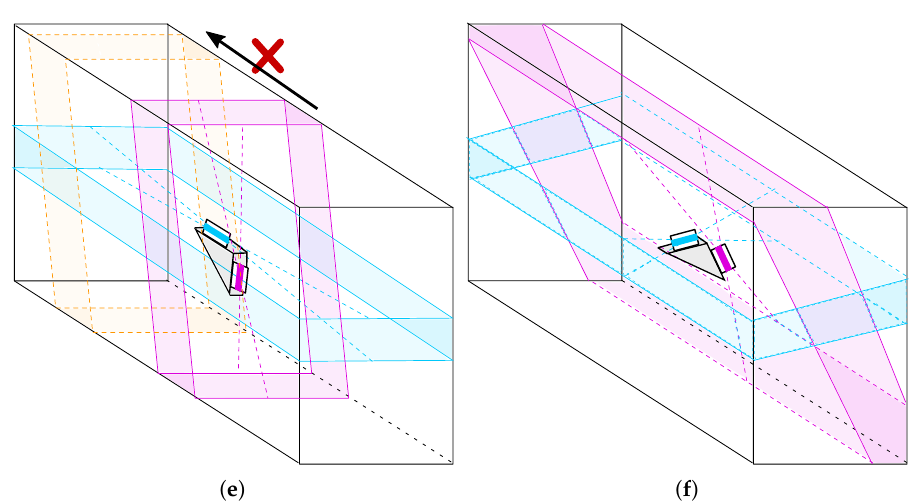
Figure 6. Various configurations of LiDAR scanners in worst case scenarios we have encountered in our experiments: narrow corridor ( a , c ) and staircase ( b ). The field of view (30 ◦ for Velodyne Puck) is displayed in color. When only single LiDAR ( a ) was used, the scans did not contain 3D information of the floor or the ceiling (red cross). The situation was not improved when the scanner is tilted because of failing in, e.g., staircases ( b ). When we added a second LiDAR, our tiled asymmetrical configuration ( d ) provides better top–bottom and left–right observation than the symmetrical one ( c ). Moreover, when the LiDARs are aligned in direction of movement ( e ), there is no overlap between current (violet) and future (yellow) frame, leading to lower accuracy. In our solution ( f ), the LiDARs are aligned perpendicularly to the walking direction solving all mentioned